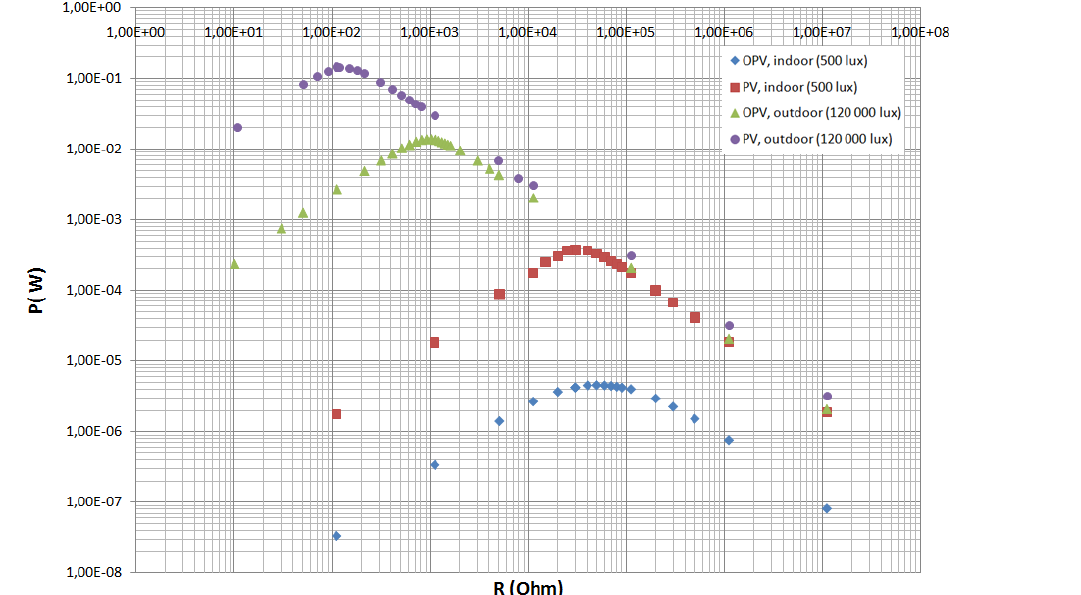
Figure 2. Comparison of the power (P in Watts) harvested between photovoltaic (PV) and organic photovoltaic (OPV) in in/outdoor standard conditions. The curves have been normalised to the surface of the two